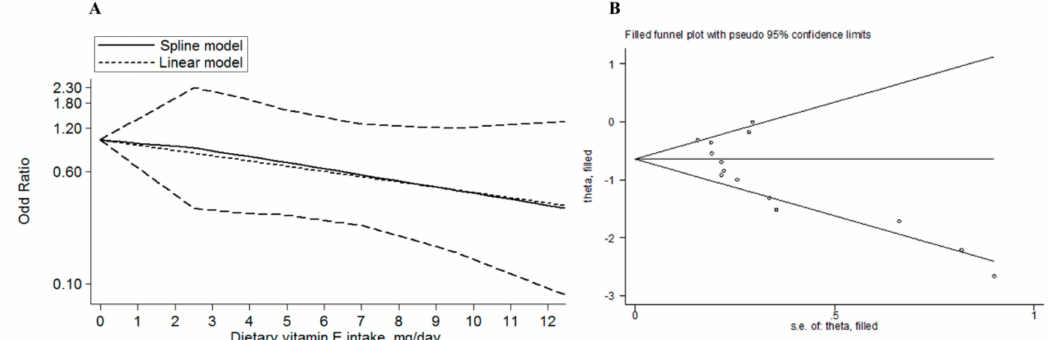
Figure 3. ( A )The dose-response analyses for the association between dietary vitamin E intake and the esophageal cancer risk. The solid line and the long dash line represent the pooled OR and corresponding 95% CI. The short dash line represents the linear association; ( B ) The funnel plot with trim and fill analysis for studies on the association between dietary vitamin E intake and the esophageal cancer